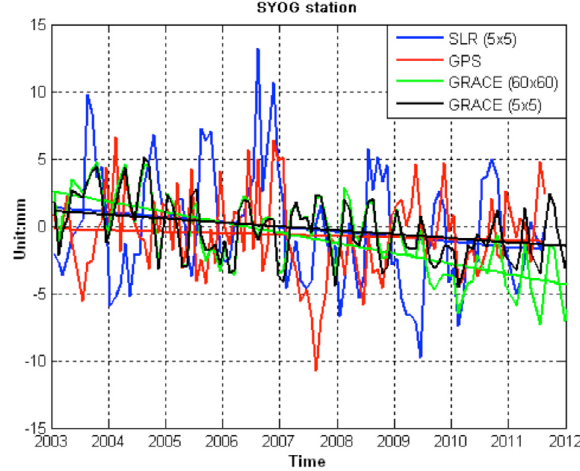
Figure 6. Time series of vertical displacement estimated from SLR 5×5 (green), GPS (red), GRACE 60×60 (blue) and GRACE 5×5 (black) at SYOG station (69.5°S, 39.5°E).